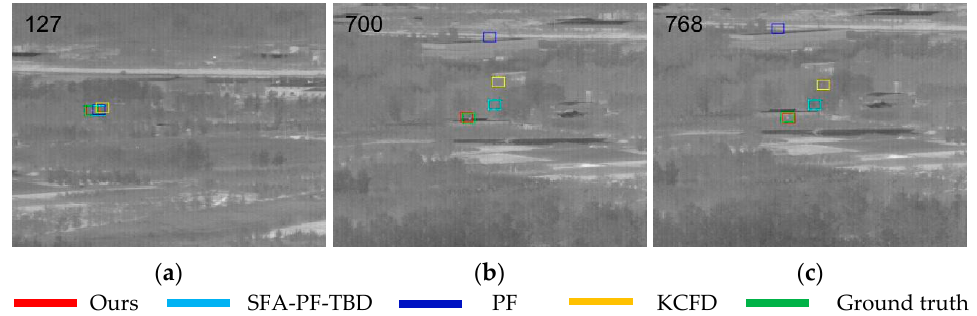
Figure 1. Tracking results of four methods for data5. ( a ) Results at frame 127; ( b ) results at frame 700; ( c ) results at frame 768.